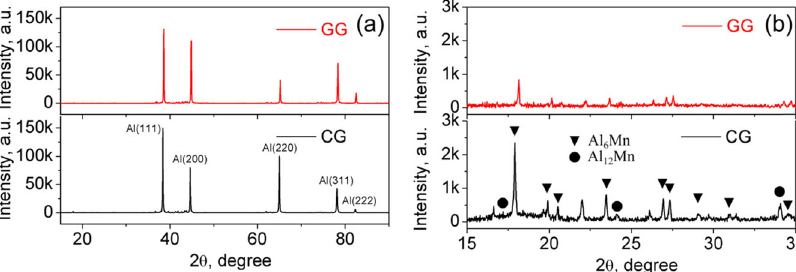
Fig. 2 XRD patterns of CG and GG Al – Mn alloys. a XRD patterns with 2 θ ranges from 15 o to 90 o and b XRD patterns with 2 θ ranges from 15 o to 35 o showing the partial dissolving of Mn-rich particles after gradient